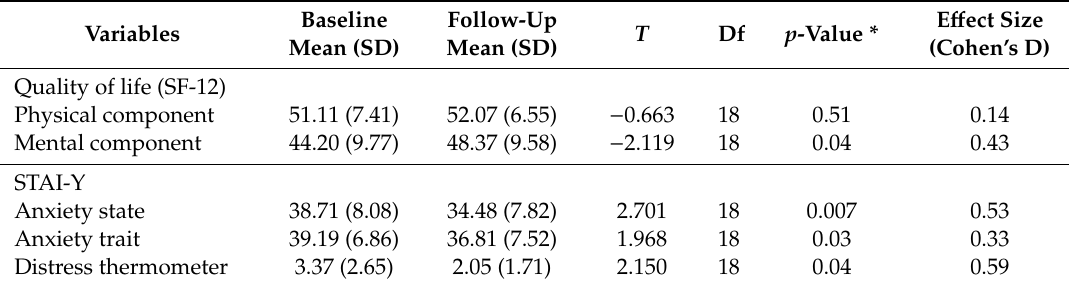
Table 1. Mean scores of the quality of life, State / Trait-Anxiety Inventory form Y (STAI-Y) and distress thermometer questionnaires of breast cancer survivors ( n = 19) at baseline and at follow-up after a one week sailing